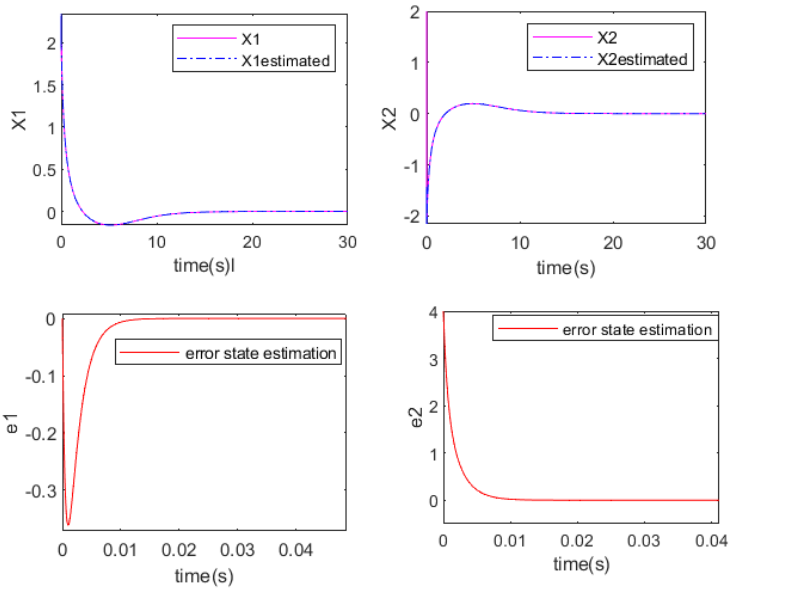
Figure 2. State evolution of T-S fuzzy model under control law obtained via Theorem